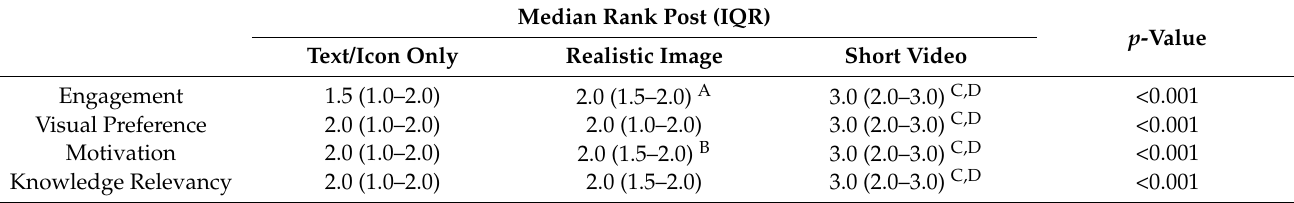
Table 2. Median (IQR) Rank of Mock Instagram Posts. Friedman test was used to determine if there was a difference between the three post styles. Post hoc analysis conducted using Wilcoxon signed-ranks test with a Bonferroni correction applied to determine differences between the post styles, significance indicated by alphabetical superscripts.